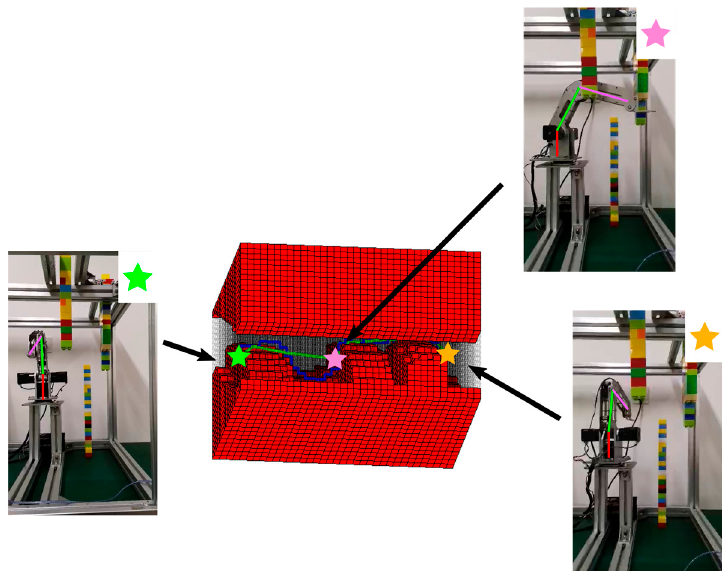
Figure 20. The path generated with the IDCS method (dark blue) and the Opti-IDCS method (green) for the second experiment. The robot pose when it reaches the specified position is shown as